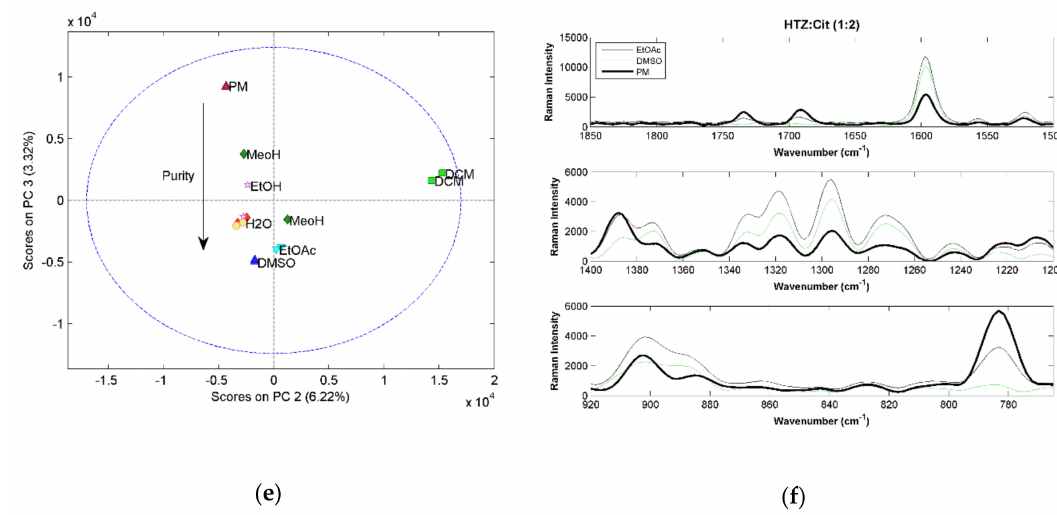
Figure 4. ( a ) PCA score plot constructed with the MIRS spectra from the system HTZ:Cit (1:2); ( b ) MIRS spectra of the samples produced with DMSO and EtOAc and from the PM; ( c ) PCA score plot constructed with the NIRS spectra from the HTZ:Cit (1:2); ( d ) NIRS spectra of the samples produced with DMSO and EtOAc and from the PM; ( e ) PCA score plot constructed with the RS spectra from the HTZ:Cit (1:2); ( f ) RS spectra of the samples produced with DMSO and EtOAc and from the PM. Colors refer to different solvents (dark green: MeOH; pink: EtOH; red: Ace; green: DCM; dark blue: DMSO; blue: EtOAc; yellow: H 2 O; dark red: